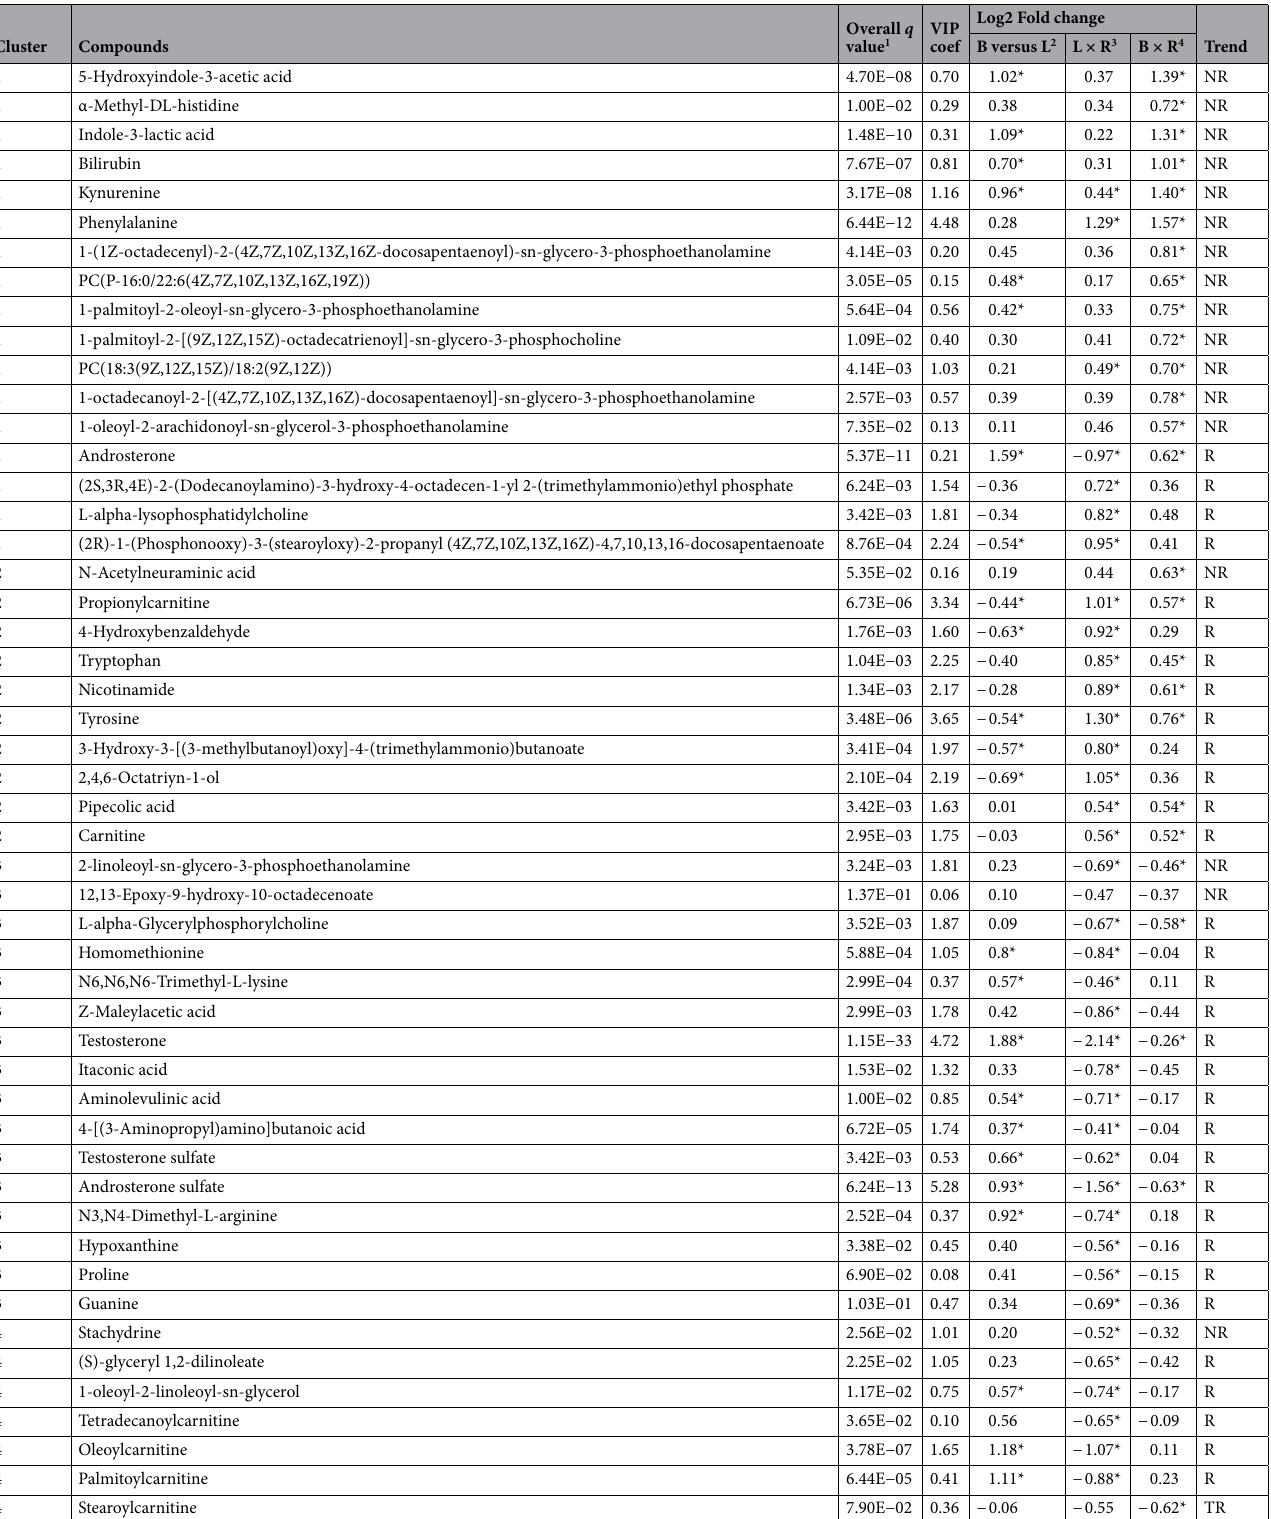
Table 1. Metabolites identified by sPLS-DA analysis. R = Recovery profile ( p value < 0.05, Low versus Restored)/TR = Tendency to recovery ( p value > 0.05, Low versus Restored))/ NR = Non-restored. 1 Overall change by ANOVA paired analysis. 2 B versus L = Basal versus Low (Basal–Low) / 3 L versus R = Low versus Restored (Low-Retored)/ 4 B versus R = Basal versus Restored (Basal–Restored) / * p value < 0.05, Pairwise comparison (Turkey Posthoc). Log2Fold Change: negative values were linked to relatively high abundant metabolites and positive values to relatively low abundant